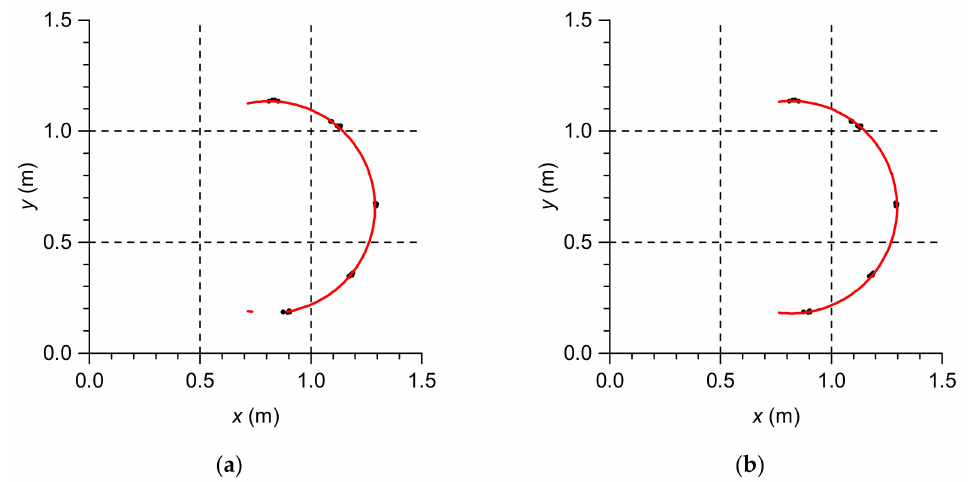
Figure 2. Graph of measuring points obtained from total station measurements to reflective foils at measurement level ( a ) 0.00 m and ( b ) 1.18